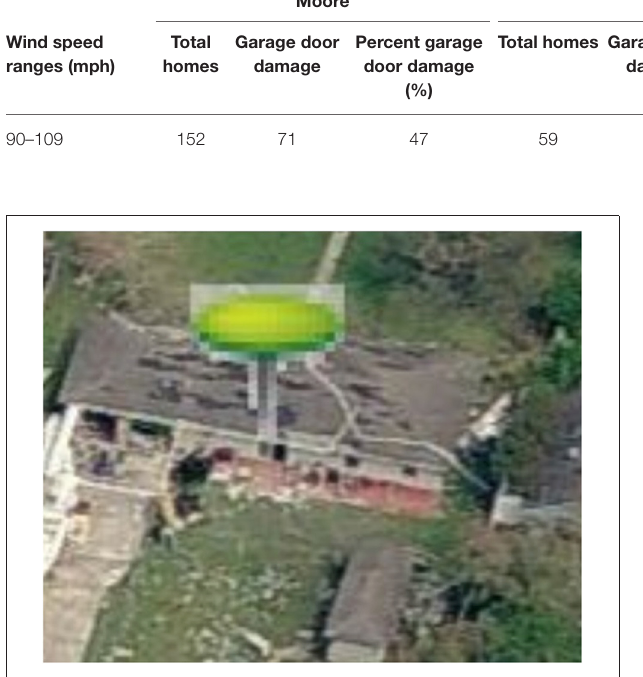
TABLE 3 | Garage door damage frequency in 90–109 mph wind speed range. Moore Joplin Ike